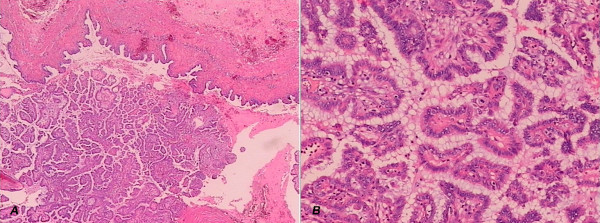
Composite figure of serous borderline tumor of the fallopian tube. A) Papillary tumor protruding into the lumen of the fallopian tube (low magnification). There is no invasion into the wall of the tube (top). B) Stratification and budding of the epithelium with focal nuclear atypia (high magnification).